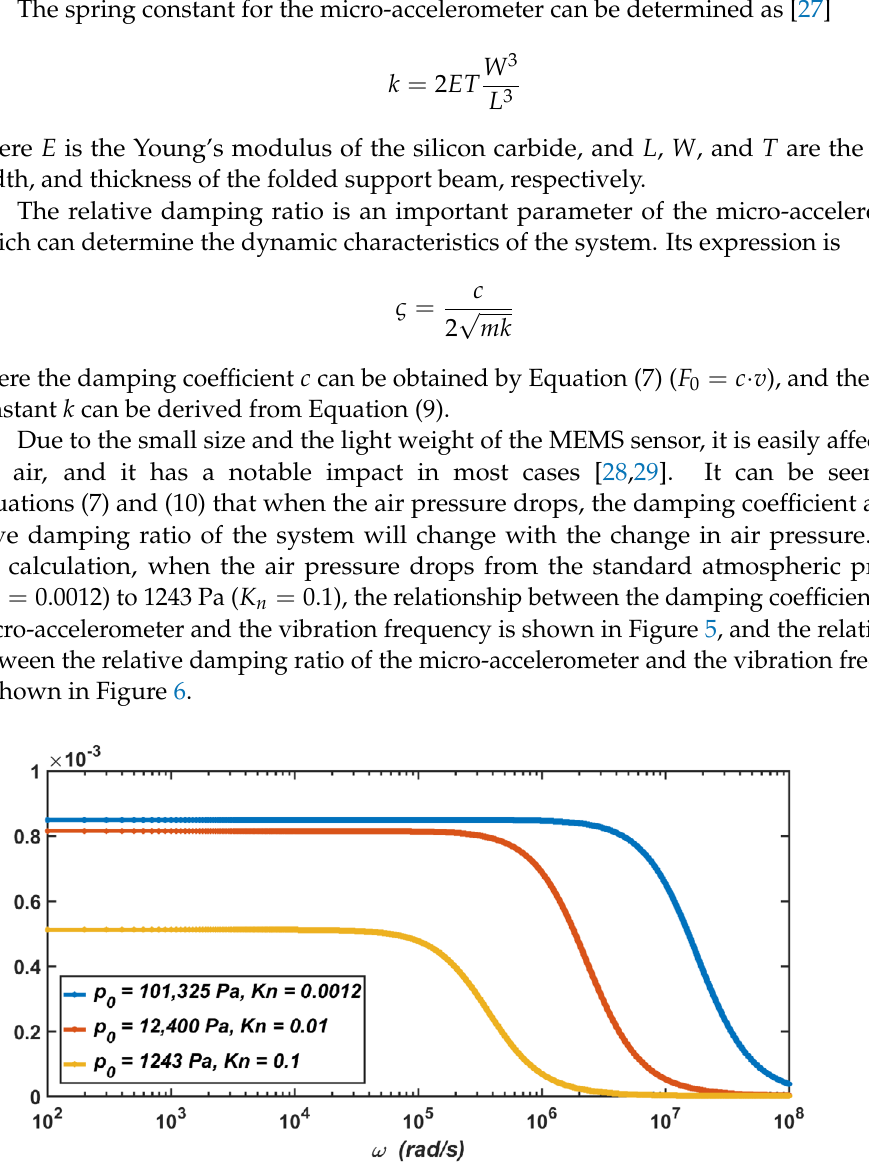
Figure 5. The dependence of the damping coefficient of the micro-accelerometer on the vibration frequency when the air pressure drops from the standard atmospheric pressure to 1243 Pa.